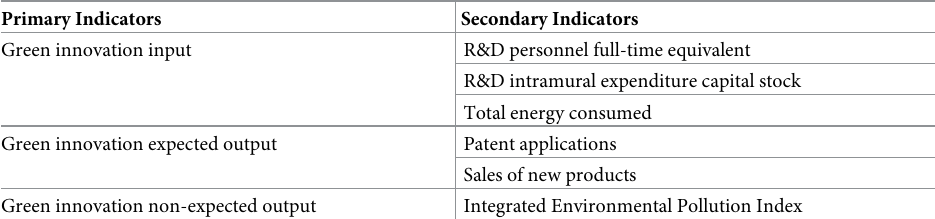
Table 1. Green innovation index system of heavy pollution